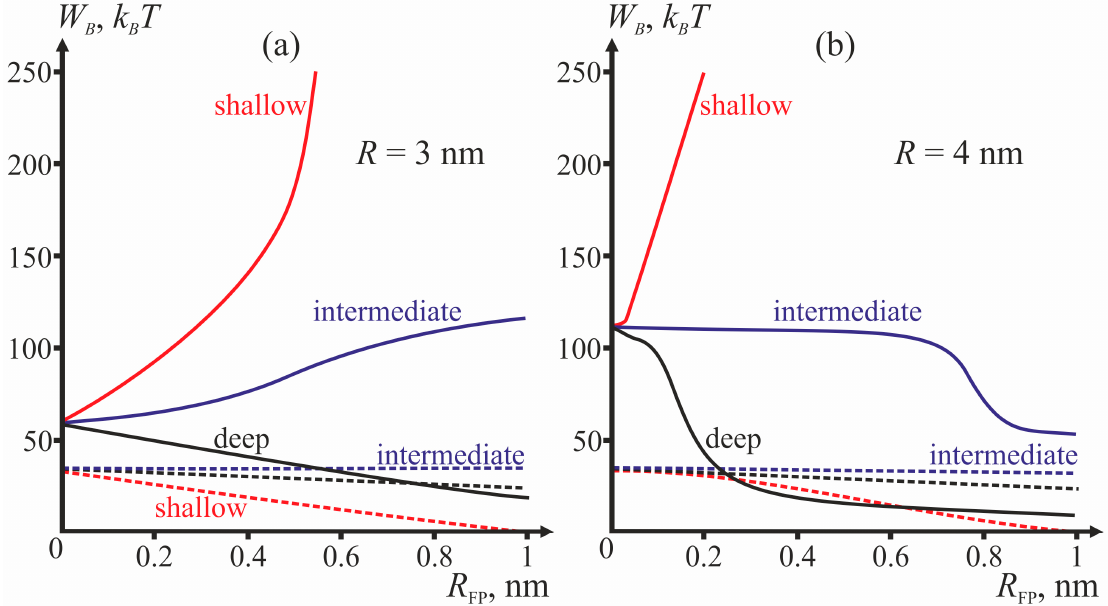
Figure 4. Dependencies of the height of the energy barrier ( W B ) for formation of the stalk (solid curves) and the π -shaped structure (dashed curves) on the half-width of the fusion peptide R FP . ( a ) fusion rosette radius R = 3 nm; ( b ) fusion rosette radius R = 4 nm. The red curves correspond to shallow insertion, the blue curves—to intermediate insertion, and the black curves—to deep insertion.